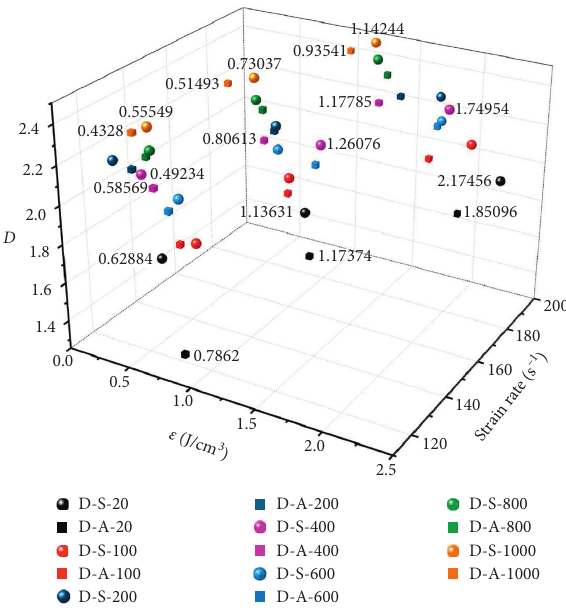
Figure 12: The relationship among mass fractal dimension, specific energy absorption, and strain